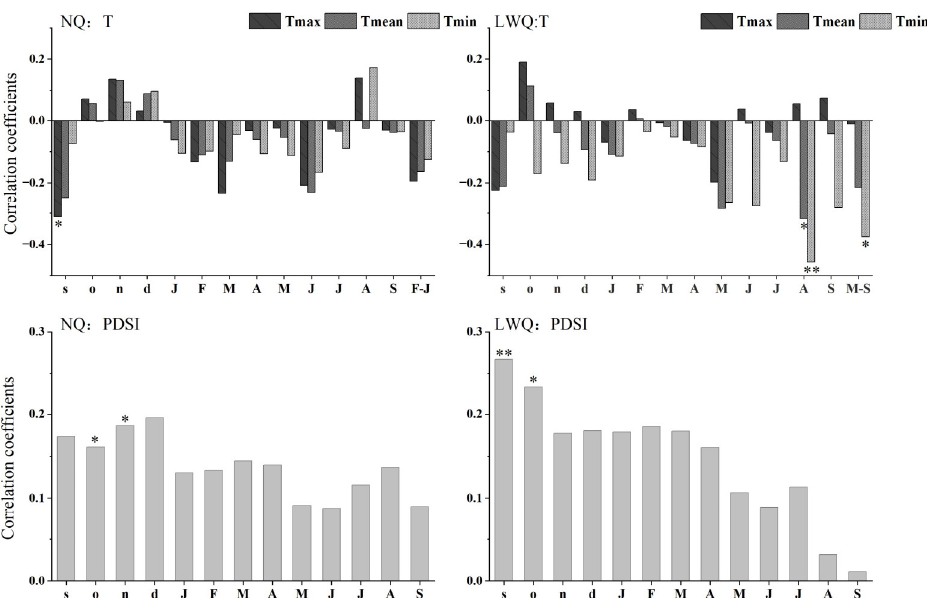
Figure 4. Correlation coefficients of shrub chronologies and climatic variables ( T , temperature variables, PDSI , drought index) from September of the previous year (lowercase letters: e.g., s, o, n, d) to September of the current year (uppercase letters: e.g., J, F, M). Abbreviations: F – J , February to June; M – S , May to September; T max , mean maximum monthly temperature; T mean , mean monthly temperature; T min mean minimum monthly temperature; PDSI , Palmer Drought Severity Index. Significance levels: *, p < 0.05; **, p < 0.01.